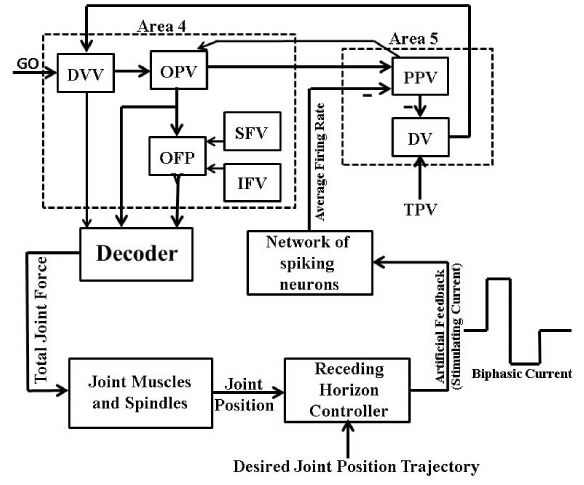
Figure 12. Receding horizon controller based closed-loop BMI design I. Here the receding horizon controller designs the “Artificial Feedback” stimulating current in a charge-balanced biphasic waveform to stimulate “Network of Spiking Neurons” such that the system output (“Single Joint Position” trajectory) mimics the “Desired Joint Position”